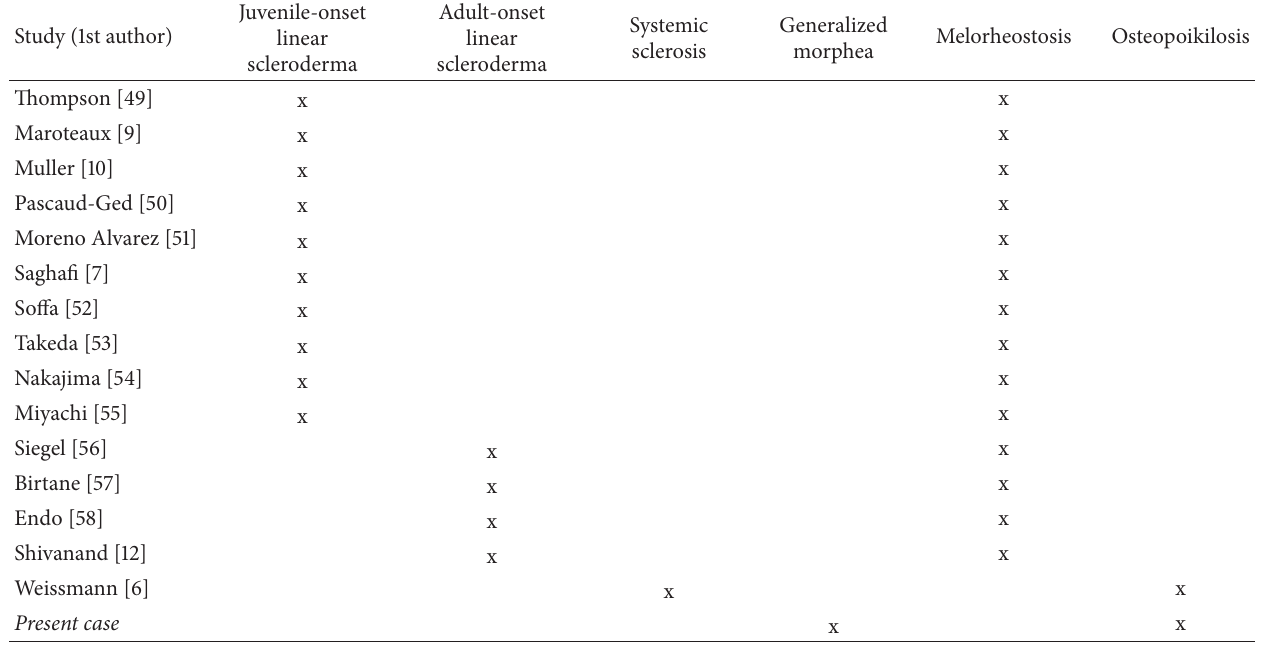
Table 2: Cases of scleroderma-spectrum disease and LEMD3 -type bony